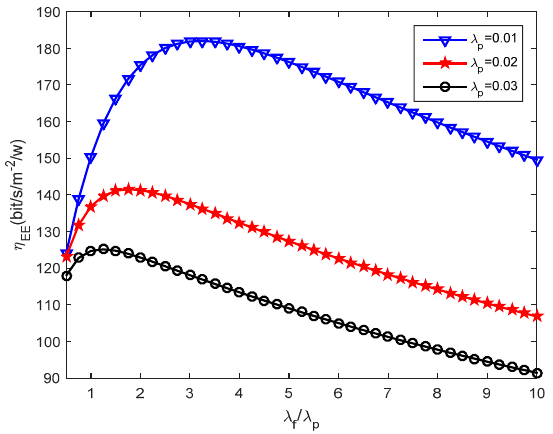
Figure 9. Energy efficiency under different picocell deployment density when T p = 6.5 dB, T f = 1.0 dB. Sensors 2016 , 16 , 1854